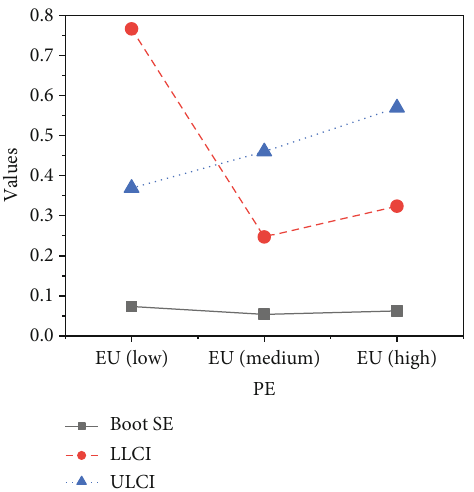
Figure 4: Mediated regulatory e ff ect numerical comparison results. Table 5: Test results of the mediated regulatory e ff ect. Mediating variable